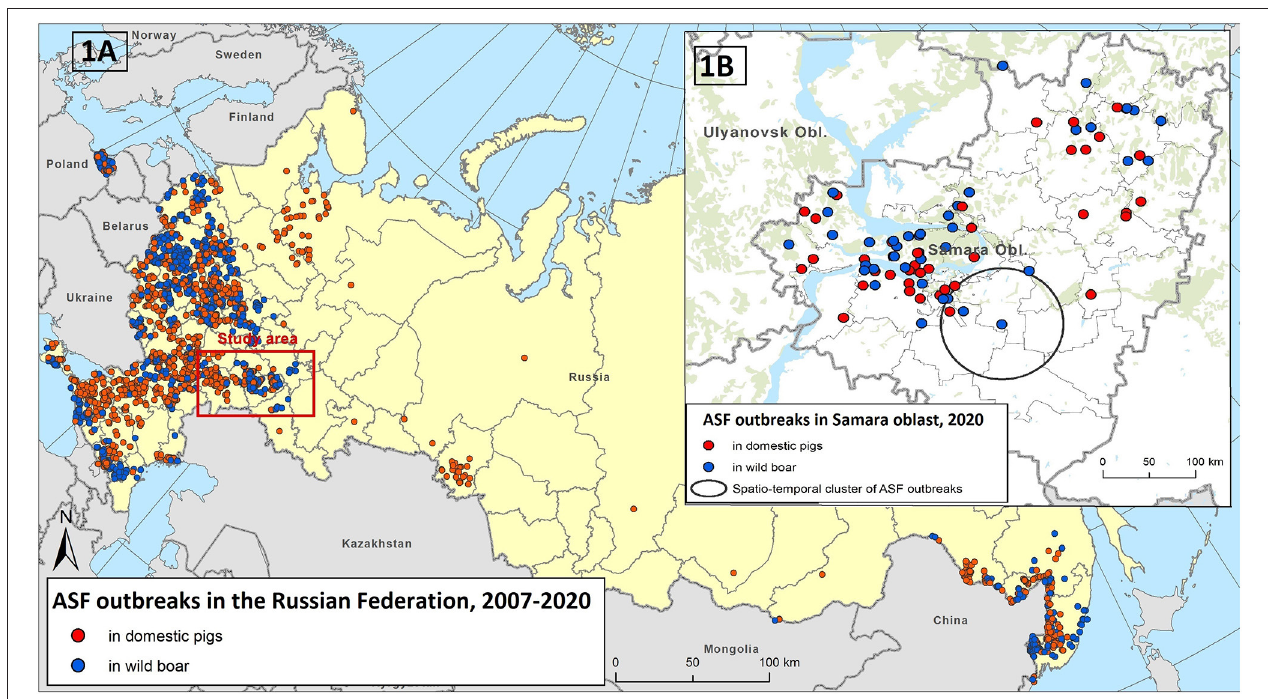
FIGURE 1 | The epidemiological overview of African swine fever (ASF) in the Russian Federation in 2007–2020 (A) . The ASF outbreaks in the Samara Oblast in 2020 and revealed spatial-temporal cluster of outbreaks (B) .